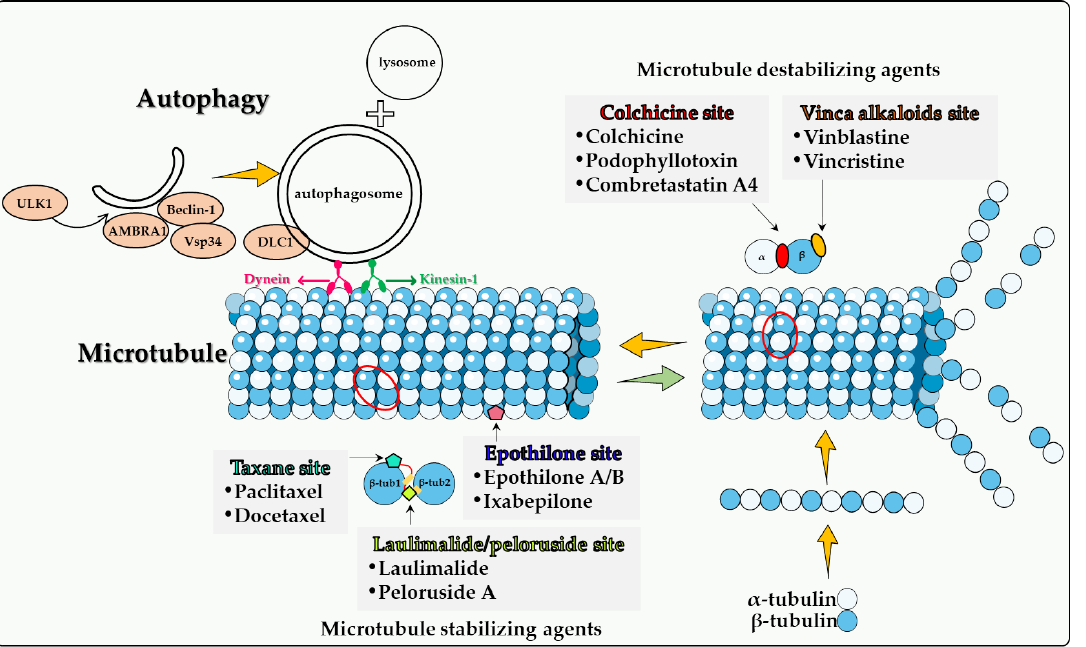
Figure 1. The binding sites of microtubule poisons and autophagy. Kinesin-1 and dynein are mi- crotubule motors that transport intracellular cargos. Once formed, the autophagosome travels along the microtubule via kinesin motor complexes, accumulating at the microtubule-organizing center, and eventually moving towards the lysosome. This centripetal movement is dependent on the motor protein dynein and is required for their fusion with lysosomes. Microtubule poisons are classified into two main categories, depending on whether they act as microtubule destabilizing agents or microtubule stabilizing agents. Microtubule destabilizing agents: Colchicine, Podophyllotoxins and Combretastatin A- 4 target the colchicine site between α - and β -tubulin subunits (red dot); Vinca alkaloids bind to the β - tubulin subunit of the α/β -tubulin heterodimer (yellow dot). Microtubule stabilizing agents: Paclitaxel and Docetaxel target the Taxane site, binding to the β -tubulin subunit (green pentagon). Laulimalide and Peloruside A binding involves the bridging of two adjacent tu- bulin dimers (β - tubulin1 and β -tubulin2) across protofilaments in microtubules (light green squares). Epothilone sites and Taxane sites are different. Among the five oxygen-containing polar groups constituting the macrocycle of epothilone, only C7-OH is located near the similar C7-OH moiety of paclitaxel, and the polymerization activity of epothilone B is 2 to 10 times higher than that of paclitaxel (pink pentagon).